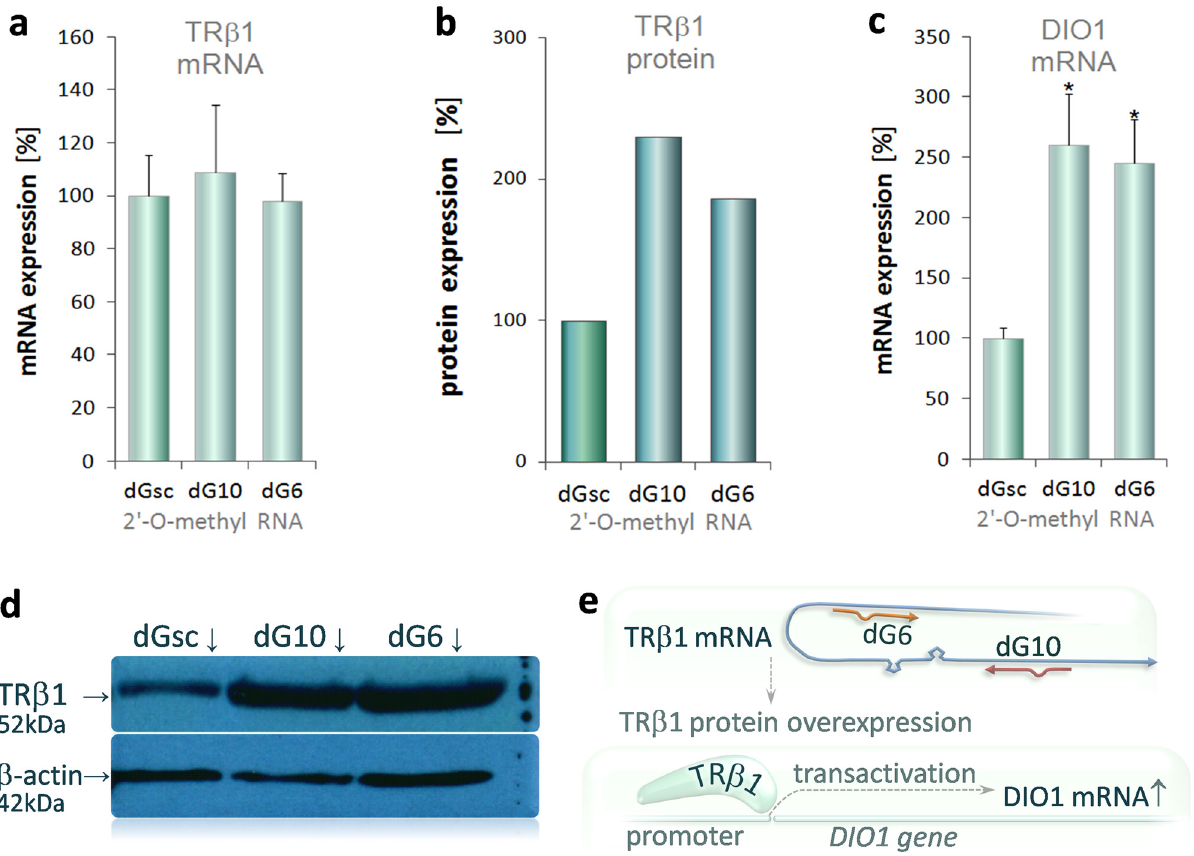
Fig 7. Effects of selected dGs on expression of endogenous TR β 1 in Caki-2 cells. Caki-2 cells were transfected with 2 ’ -O-methyl- modified RNA-based dG6, dG10 or scrambled control — dGsc and cultured (without any plasmid) according to the procedure used in translation-enhancing assay (Materials and Methods). dGs were selected on the basis of previously obtained results (Fig 6). Expression of TR β 1 mRNA ( a ), protein ( b ) and DIO1 mRNA ( c ) are shown in upper panel. Semi-quantitative real-time PCR was performed for TR β 1 (exon 2 – 3) and DIO1, as described before [23]. Data from three independent experiments were performed in triplicate and shown as mean values ± SD. Statistics were calculated using t-test to compare cells transfected with dGs vs. dGsc. * p < 0.001. ( d ) An example western blot for TR β 1 and β -actin is shown in lower panel. Each band (dGsc, dG10, dG6) represents sample combined from nine protein lysates. Relative density of bands was quantified by densitometry and TR β 1 protein levels were normalized to β -actin. ( e) A simplified model of dG- mediated upregulation of endogenous TR β 1 protein, which has been demonstrated before to act as a transcription factor activating transcription of multiple genes including type 1 iodothyronine deiodinase